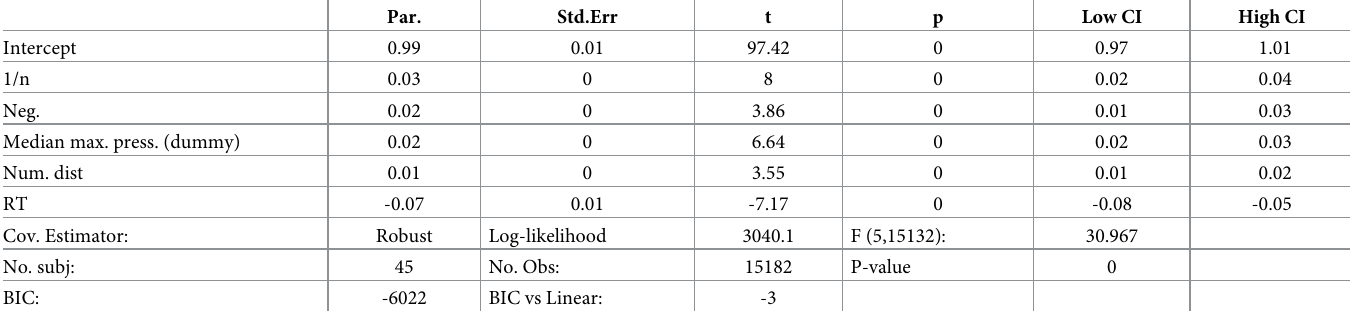
Table 3.2. Accuracy. Exp. 3 . Fixed Effects Estimation.